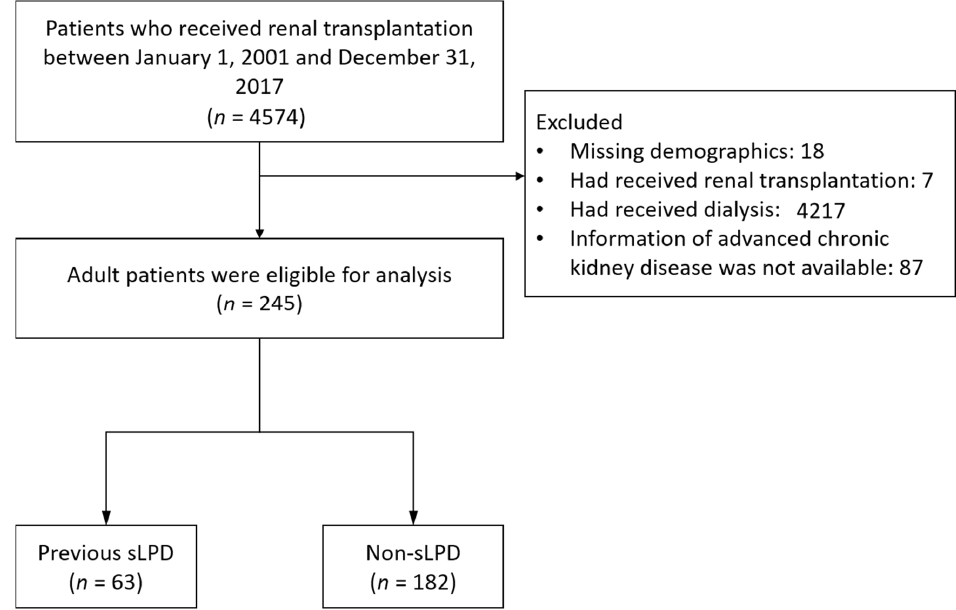
Figure 1. Inclusion criteria of the study patients. sLPD: ketoanalogue-supplemented low-protein